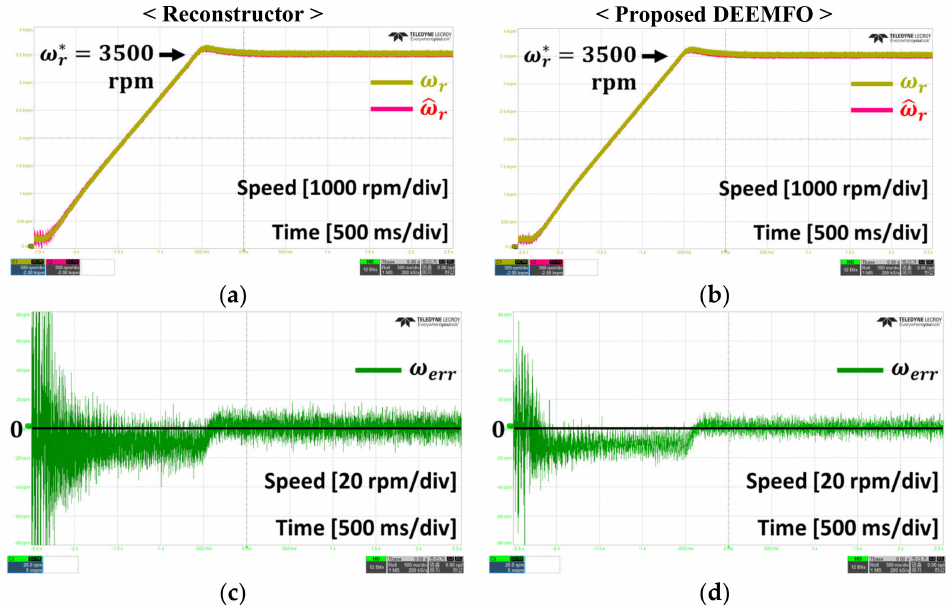
Figure 17. Summary of the experiment results provided for the parameters of IPMSM changed by 30%. ( a ) reference, real, and estimated speed with reconstructor; ( b ) reference, real, and estimated speed with DEEMFO; ( c ) speed error in reconstructor; ( d ) speed error in